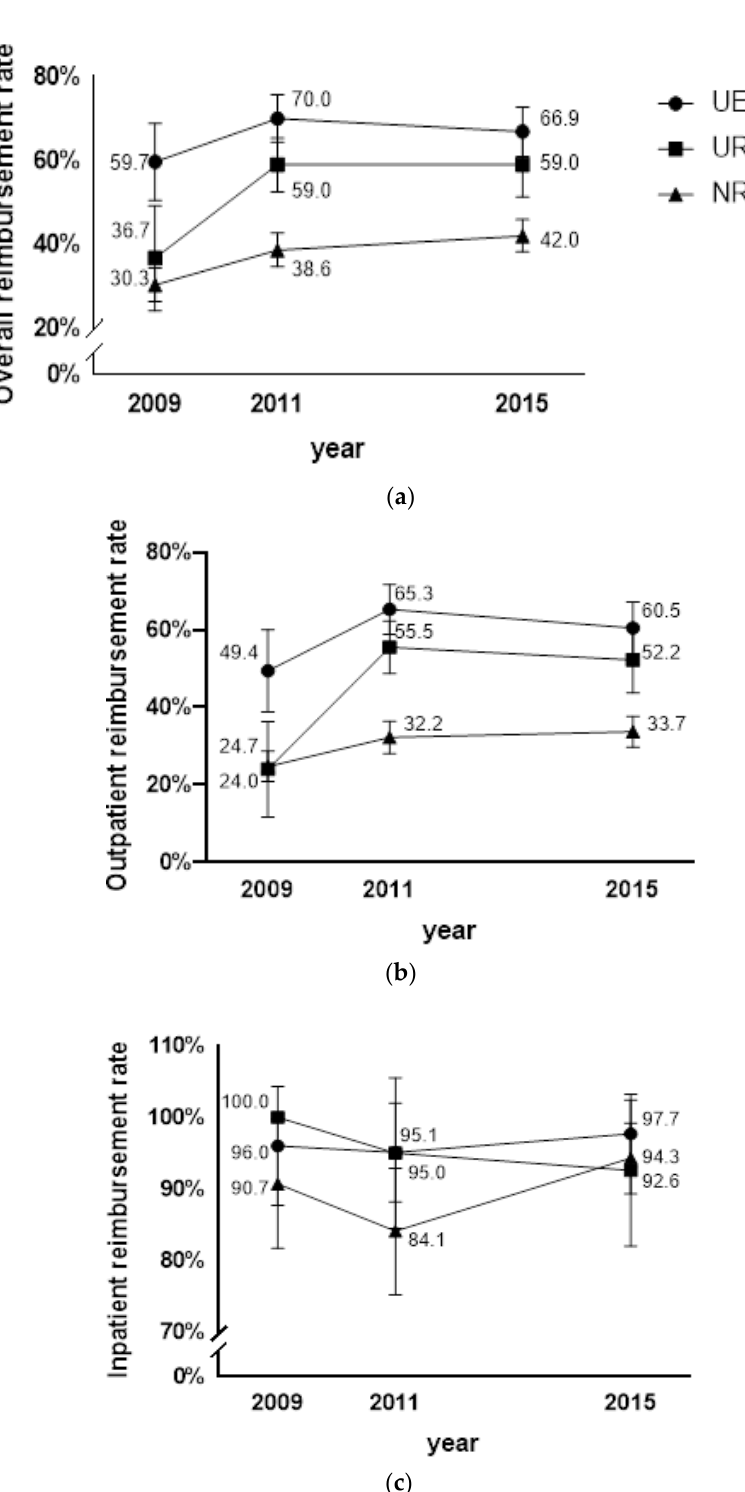
Figure 1. ( a ) Trend of overall reimbursement rate by year (with 95% confidence intervals) and social health insurance schemes in China; ( b ) Trend of outpatient reimbursement rate by year (with 95% confidence intervals) and social health insurance schemes in China; ( c ) Trend of inpatient reimbursement rate by year (with 95% confidence intervals) and social health insurance schemes in China.